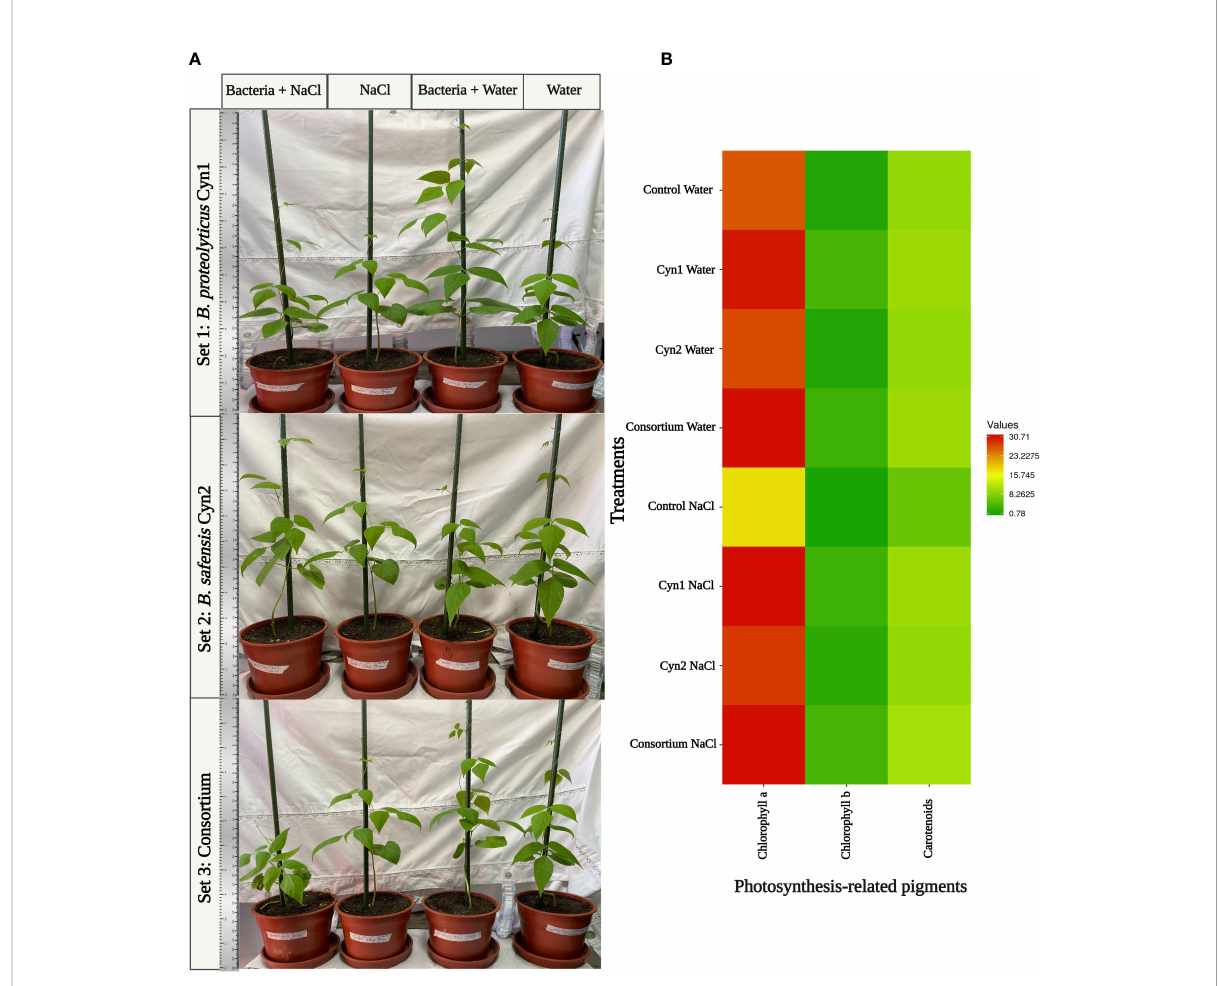
FIGURE 8 (A) Evaluation of B. proteolyticus Cyn1, B. safensis Cyn2, and their consortium as candidates for the growth of Chilean local “ Sapito ” variety of common beans under normal conditions and induced salinity stress in pot experiments. (B) Photosynthesis-related parameters chlorophyll